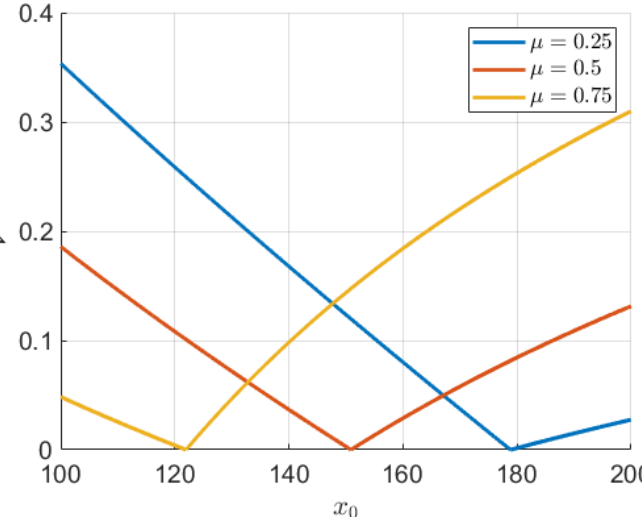
Figure 4. Value of information for different x 0 and different µ under the assumption that the initial guess (cid:98) x 0 is chosen optimally in the sense of